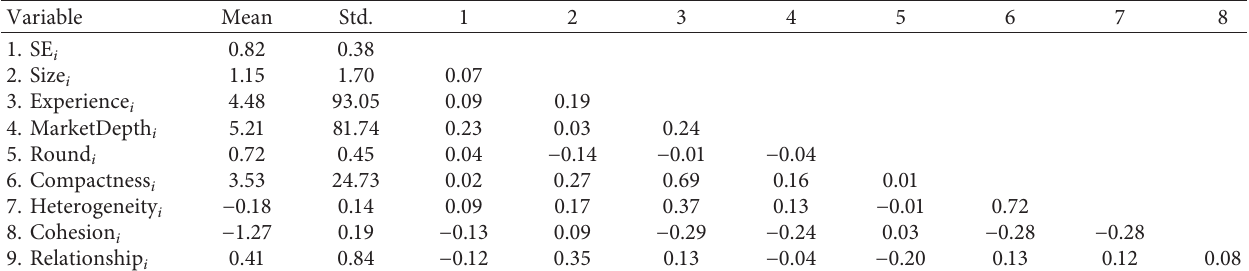
Table 2: Descriptive statistics and correlations of variables.